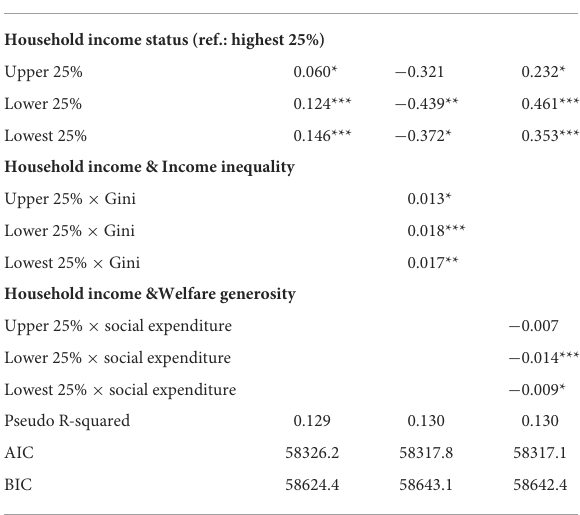
TABLE 3 Fixed effect models: main effect and interaction effects on the occurrence of feeling lonely for older adults ( N =